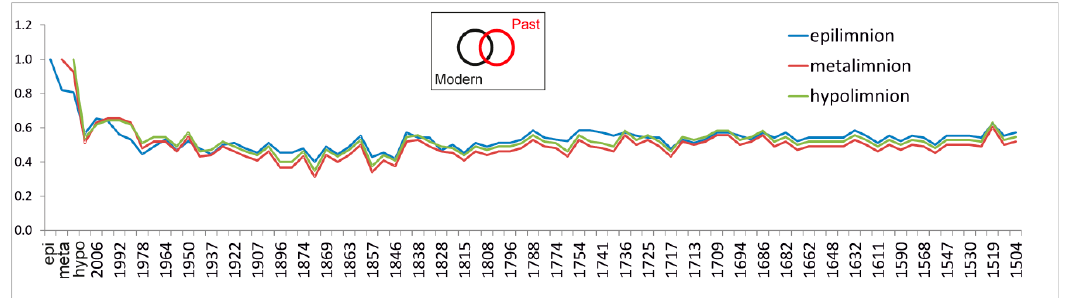
Figure 9. Comparison of Sorensen’s similarity index (S) between modern and sediment samples. A Venn diagram comparing modern and past pigment assemblages is shown in the upper right corner. Epi-, meta-, hypo- refer to current in-depth layers of the water column. Abcissa: dates inform about the age of the sediment samples, Ordinate: S values.